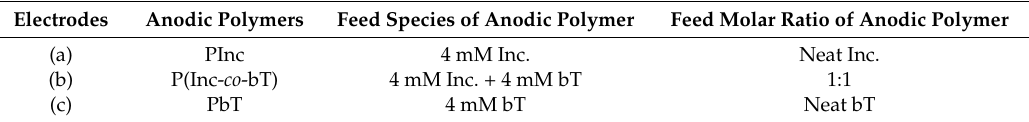
Table 1. Feed species of anodic polymer electrodes